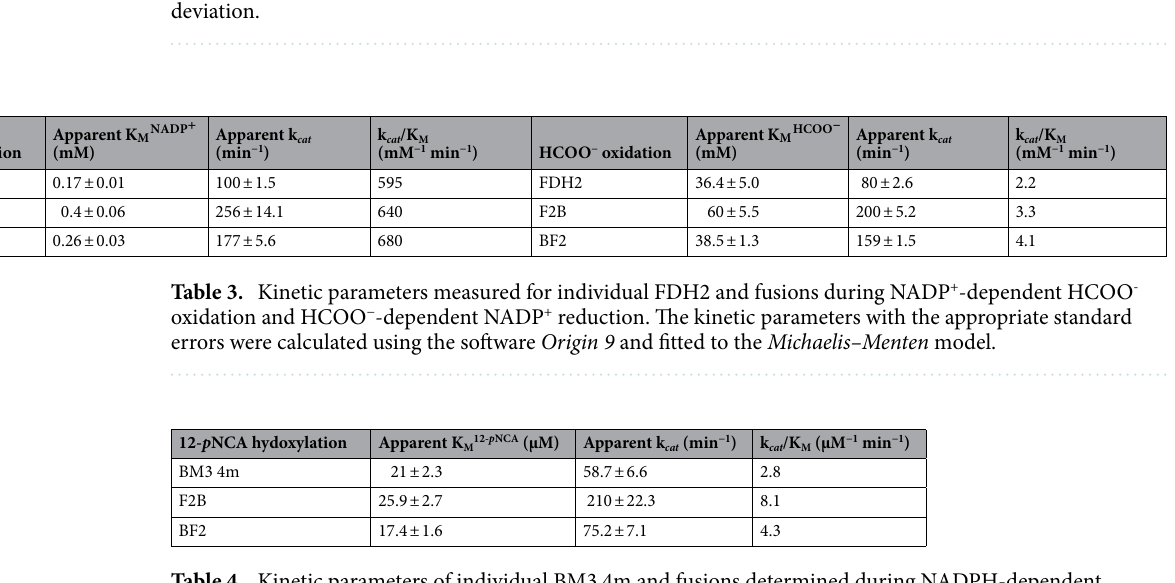
Table 4. Kinetic parameters of individual BM3 4m and fusions determined during NADPH-dependent 12- p NCA hydroxylation. The kinetic parameters with the appropriate standard errors were calculated using the software Origin 9 and fitted to the Michaelis–Menten